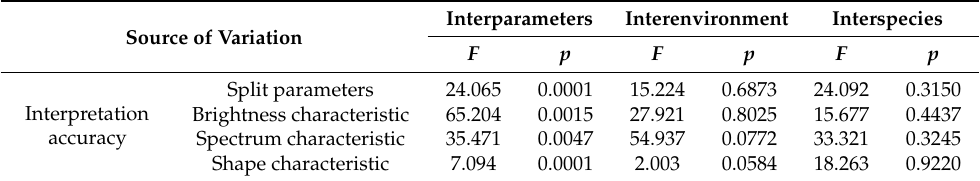
Table 2. Differences in the interpretation results of the stomatal images based on segmentation parameters and extraction rules.